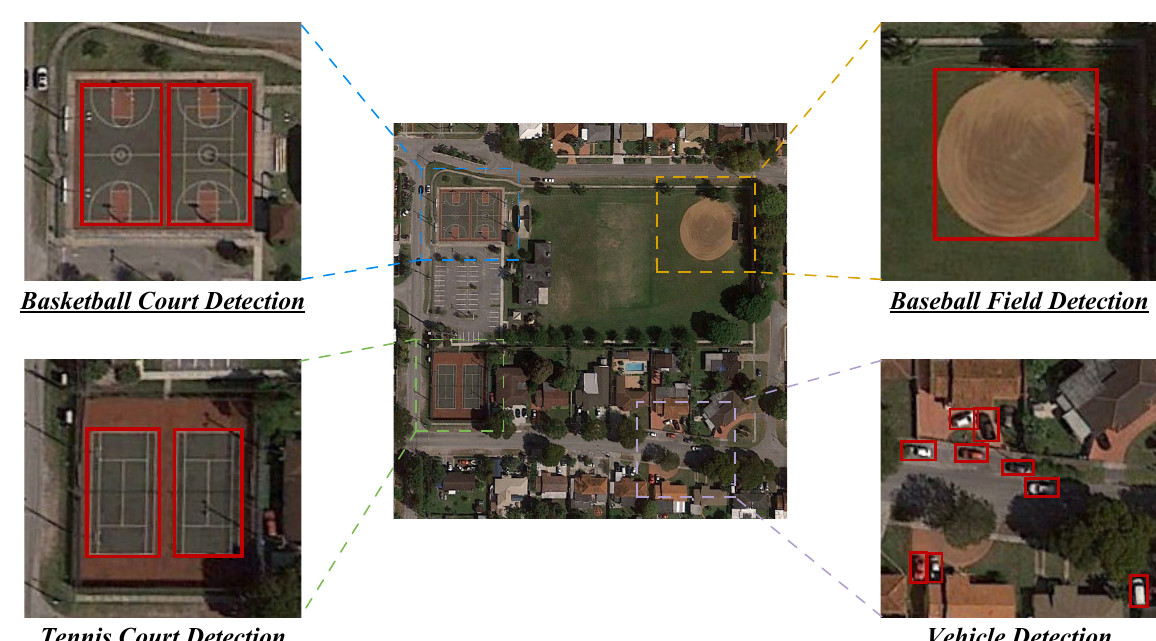
Figure 1. Characteristics of remote sensing images, i.e., small object scale and complex background objects.